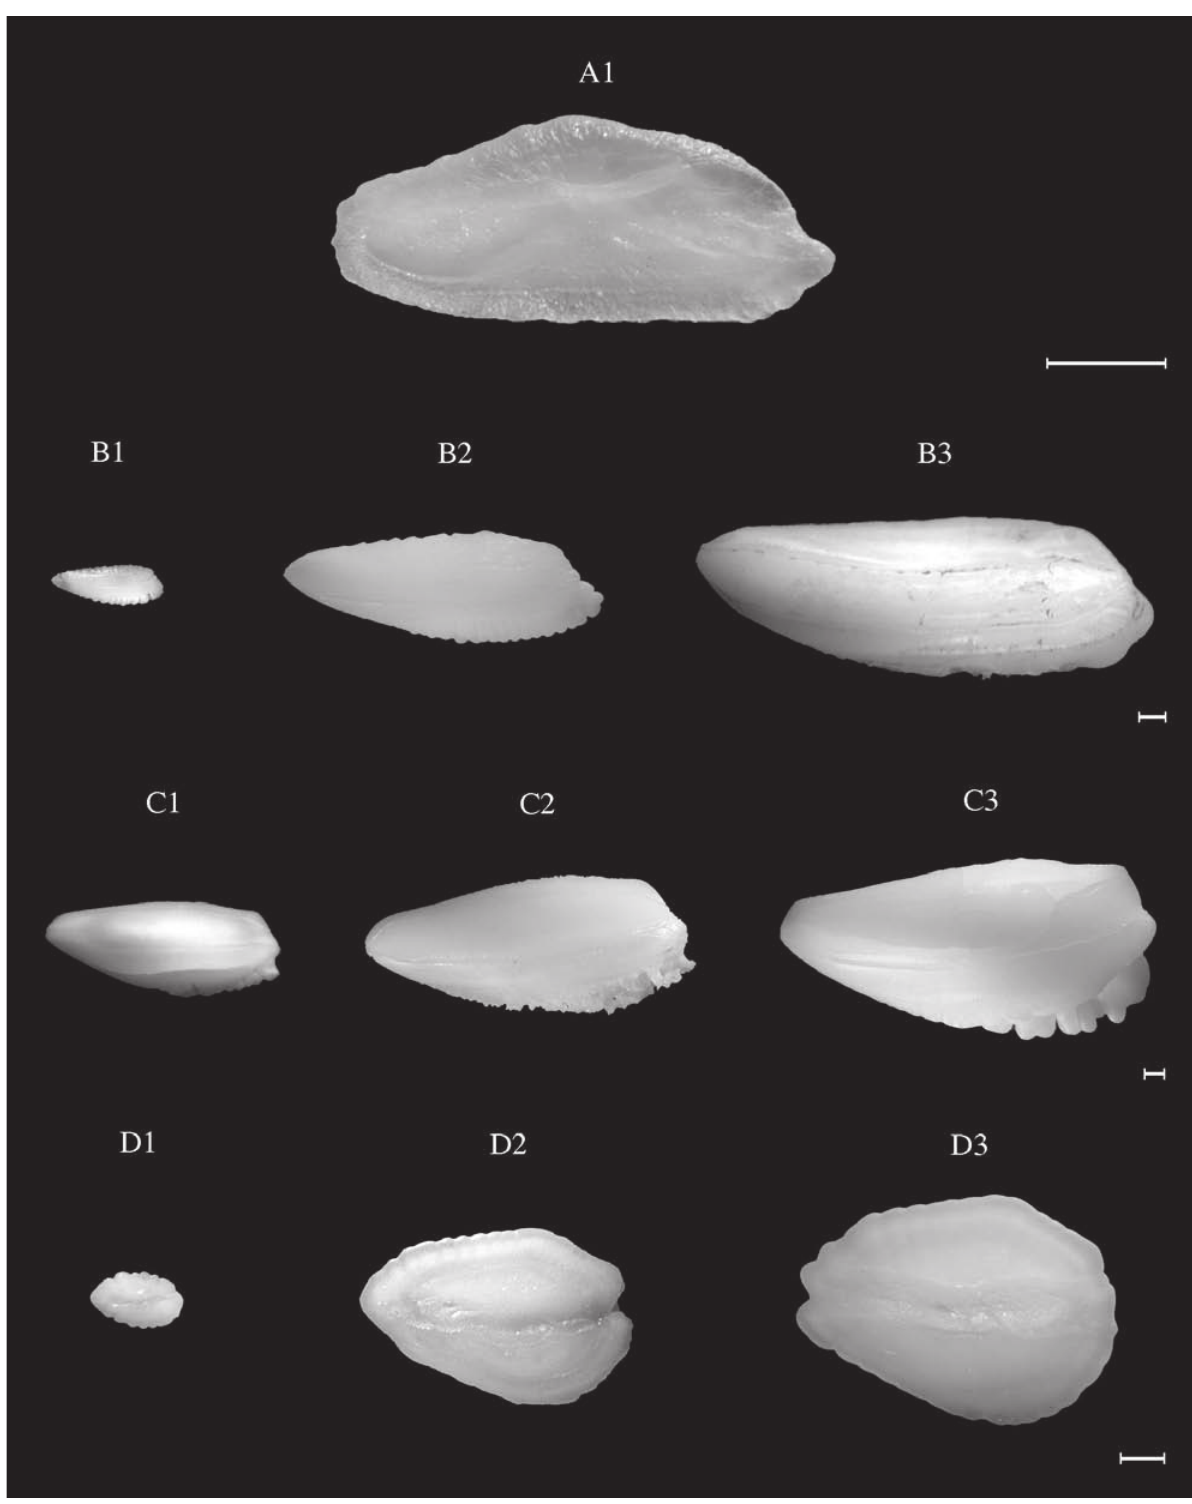
Fig. 30. – Gaidropsarus mediterraneus (NEA). TL: A1, 23.3 cm. Phycis blennoides . TL: B1, 6.0 cm (WM); B2, 26.0 cm (NEA); B3, 55.0 cm (WM). Phycis phycis . TL: C1, 21.5 cm (WM); C2, 34.5 cm (CEA); C3, 54.1 cm (NEA). Gadiculus argenteus . TL: D1, 3.5 cm (WM); D2, 9.3 cm (WM); D3, 14.5 cm (NEA). Scale bar = 1